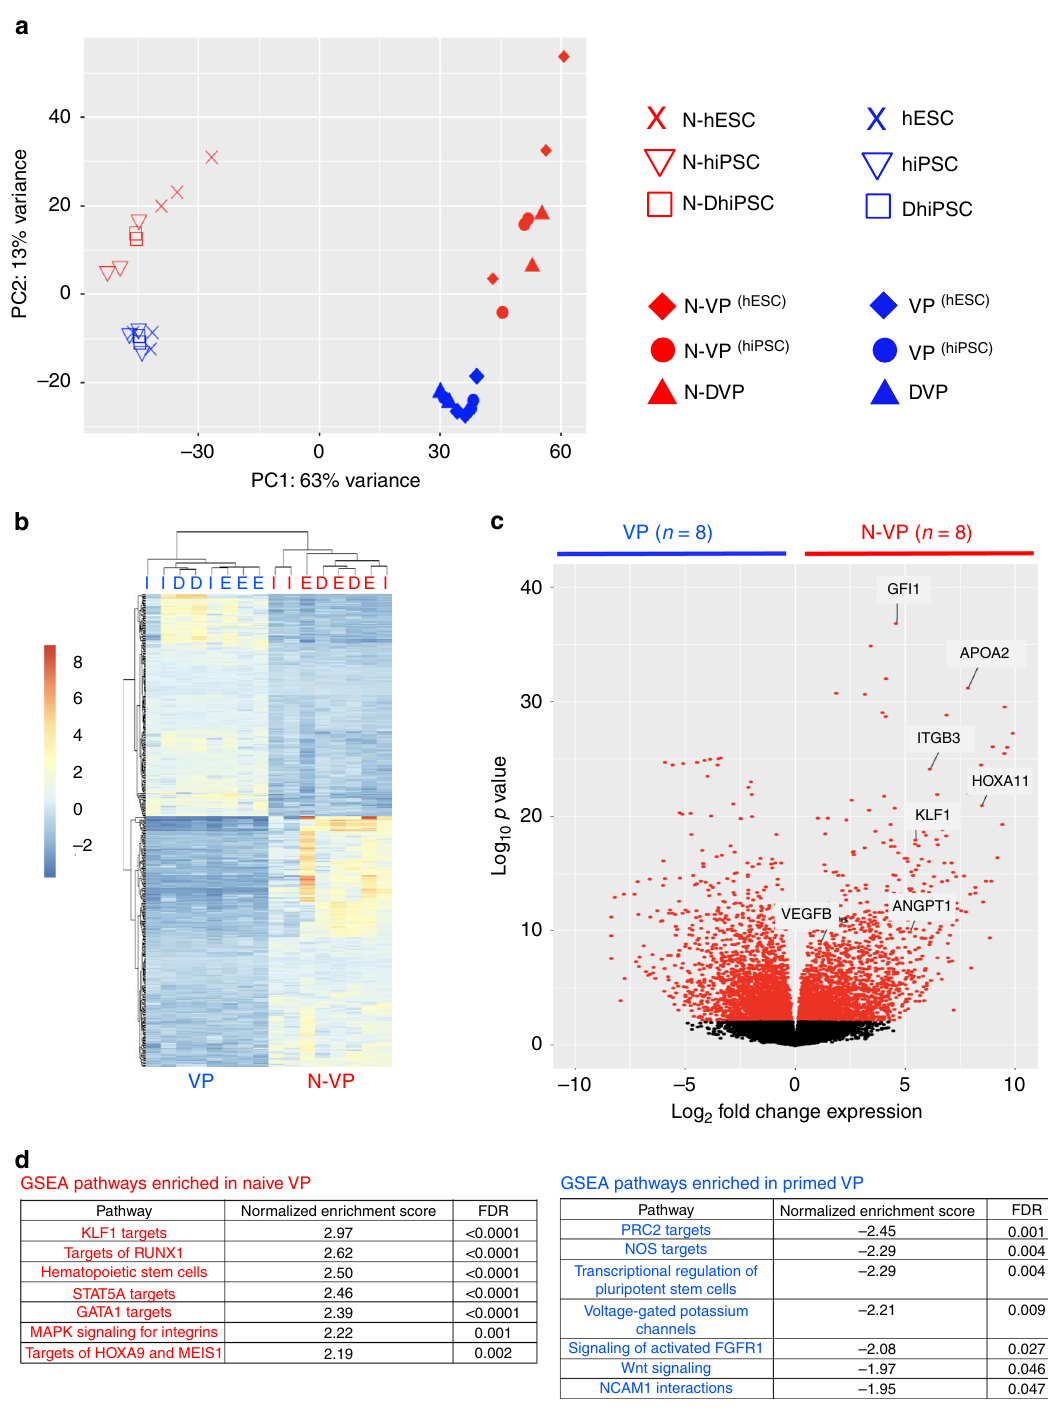
Fig. 8 Transcriptional pro fi ling of primed vs. naïve VP from normal and diabetic hPSC. a PCA of whole genome transcriptomes from RNA-Seq samples from primed VP/DVP vs. N-VP/DVP, and their parental isogenic hPSC lines (i.e., primed or naïve hESC-derived VP, primed or naïve hiPSC-derived VP, and primed or naïve DhiPSC-derived DVP). b Heatmap-cluster dendrogram of the top 500 most differentially expressed genes (Supplementary Data 4); hierarchical clustering (Euclidian distance) of isogenic primed vs. naïve VP RNA-Seq samples. Isogenic paired VP samples are same above ( n = 8; VP/DVP and N-VP/N-DVP). (hESC-derived VP or N-VP: ‘ E ’ ; hiPSC-derived VP or N-VP: ‘ I ’ ; DhiPSC-derived DVP or N-DVP: ‘ D ’ ). c Volcano plot of differentially expressed transcripts in whole genome of primed vs. naïve VP; log 10 p-values vs. log 2 fold change in expressions. RNA-Seq VP samples are same as in PCA above ( n = 8). d GSEA of pathways enriched in primed VP/DVP vs. N-VP/N-DVP. Paired isogenic primed and naive VP samples used for analysis are same as PCA ( n =